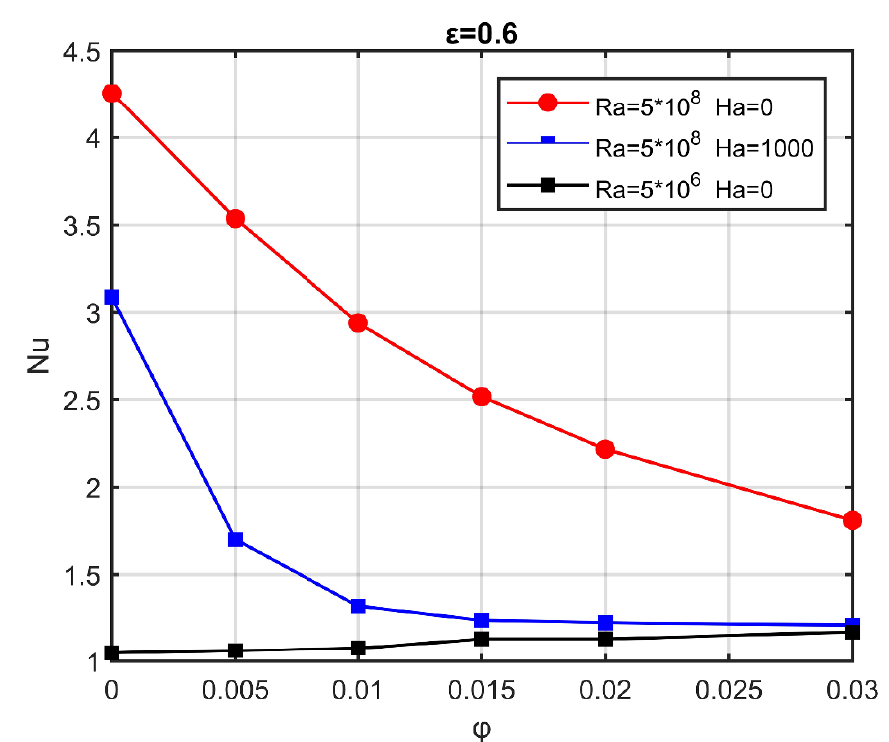
Figure 11. Average Nusselt number as a function of the volume fraction of nanoparticles, for characteristic Hartmann and Rayleigh numbers, and 𝜀 = 0.6 .